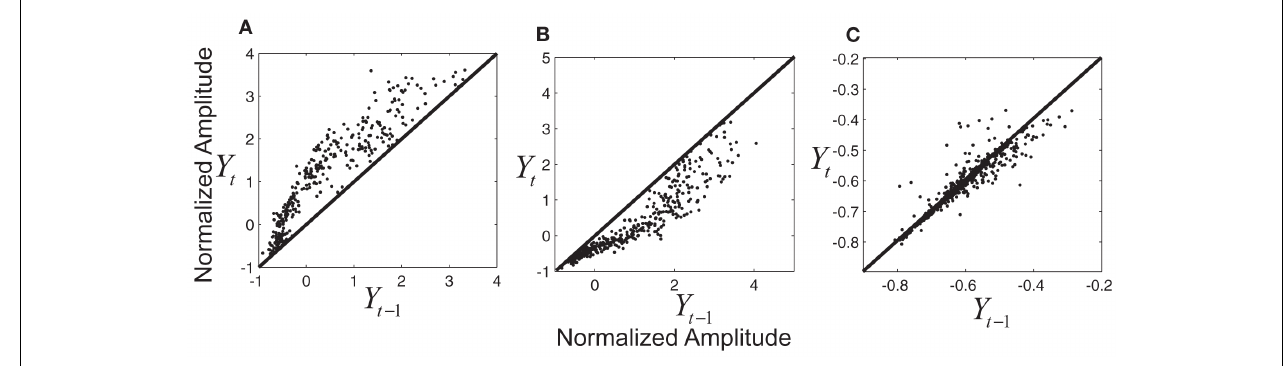
FIGURE 7 | (A) Kernel locations for ˆ p ( Y t − 1 , Y t ) under extension state; (B) kernel locations for ˆ p ( Y t − 1 , Y t ) under flexion state; (C) kernel locations for ˆ p ( Y t − 1 , Y t ) under rest state. Numbers on the axis are the normalized amplitude of the fingers’